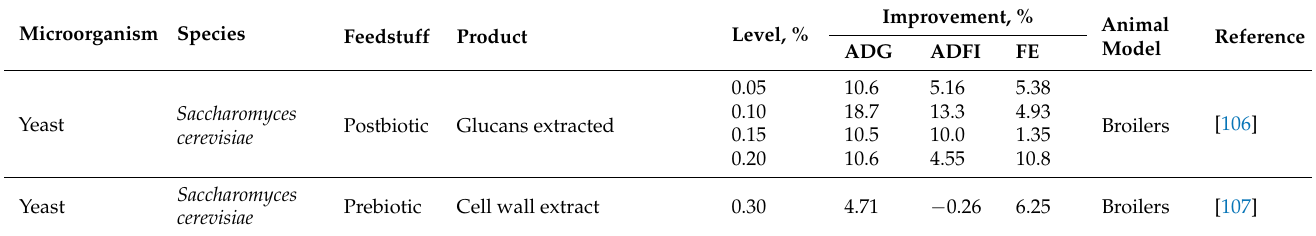
Table 3. Examples of yeasts and microalgae as functional feed